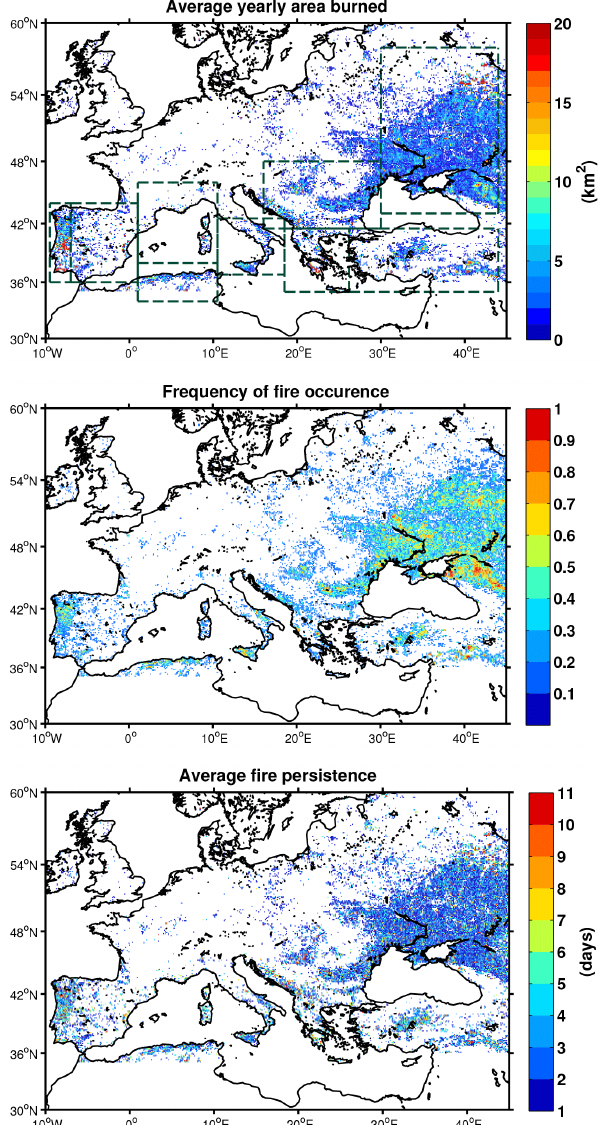
Fig. 3. Averaged total yearly burned area on a 0 . 1 ◦ × 0 . 1 ◦ grid ac- cording to the MODIS MCD64 product for the 2003–2012 time period, corresponding frequency of fire occurrence, and average du- ration of the fire events within each grid cell. Regions used for the statistical analysis are indicated in the top